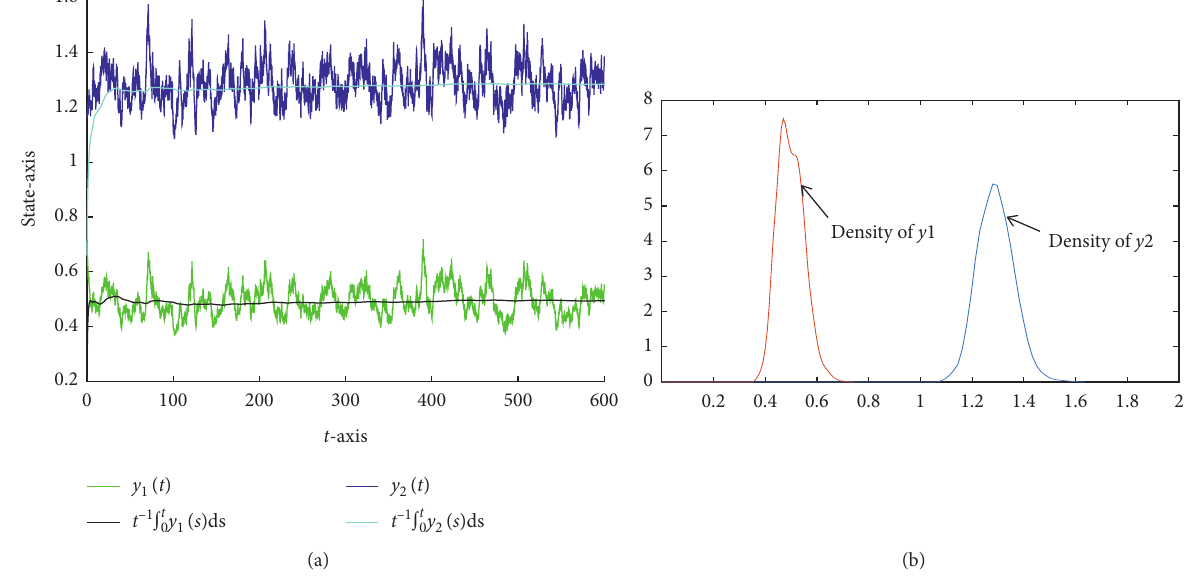
Figure 1: The persistent in mean of model ( M probability density function of c